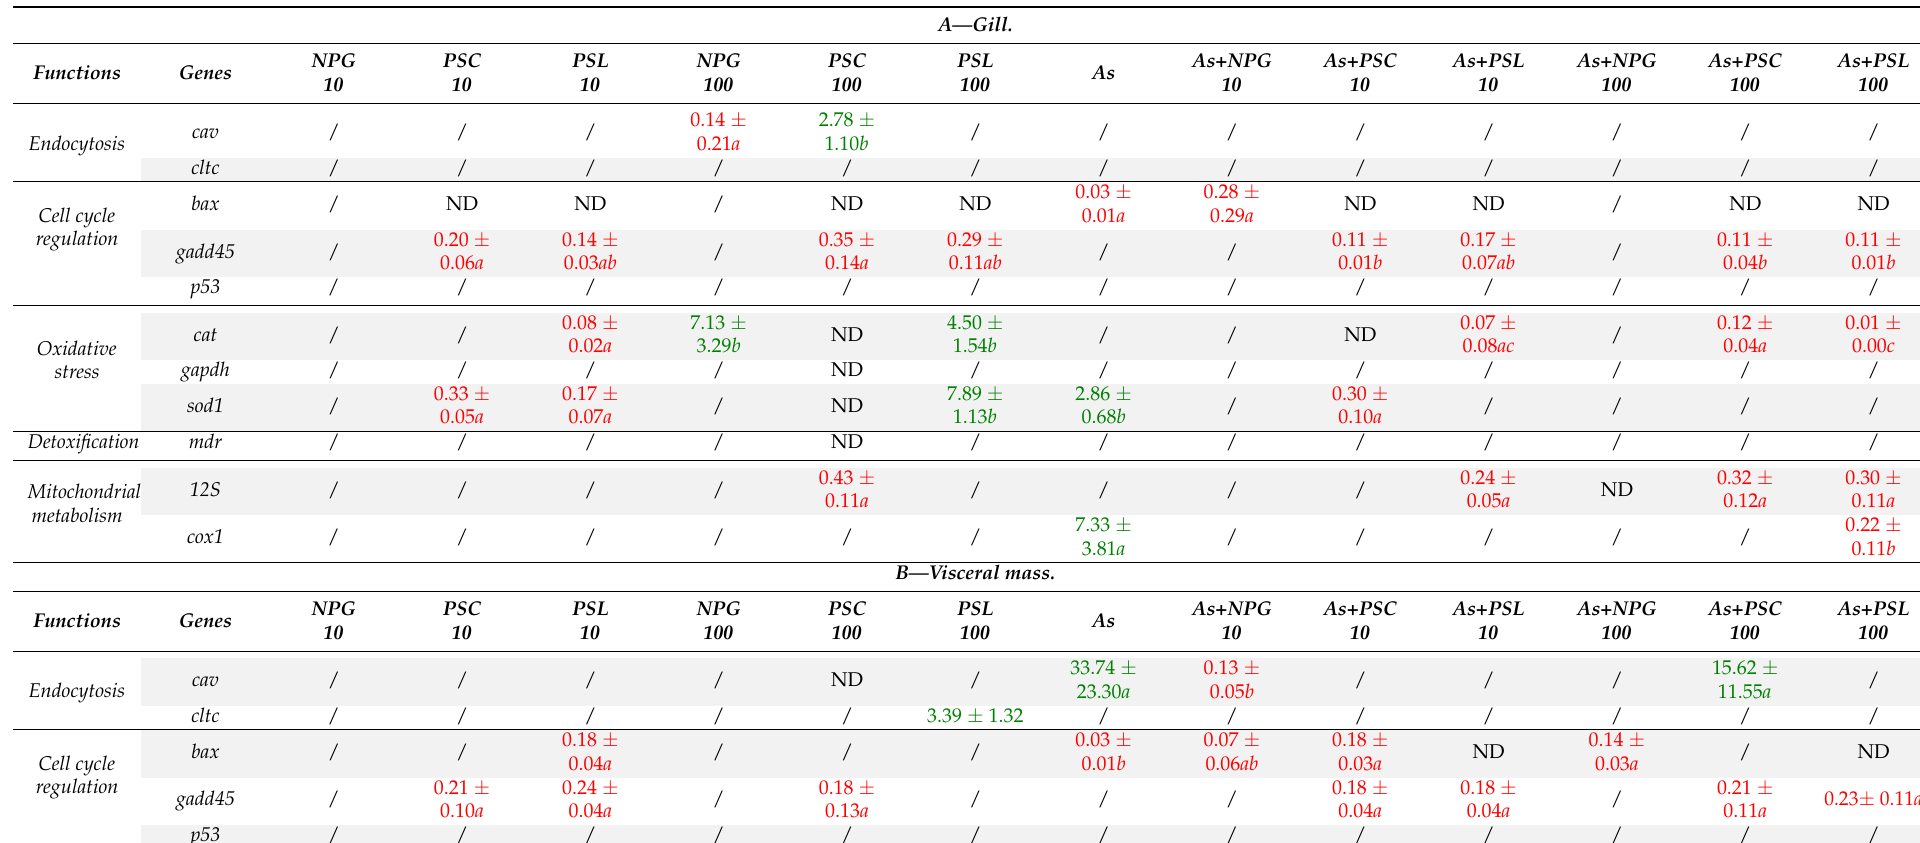
Table 2. Relative gene expression in I. alatus’ gills ( A ) and visceral mass ( B ) after one week of exposure to 10 and 100 µ g L − 1 NPs by the dietary route, combined or not with 1 mg L − 1 As in water. All the values are presented as the mean ± sd ( n = 4) of fold changes compared to control (induction in green and repression in red), previously normalized by β -actin and rpl7 reference genes. Different letters ( a and b ) denote statistically significant differences ( p < 0.05) between treatments for each gene assessed by two-way ANOVA followed by Tukey post-hoc test. / indicates no statistically significant differences with the